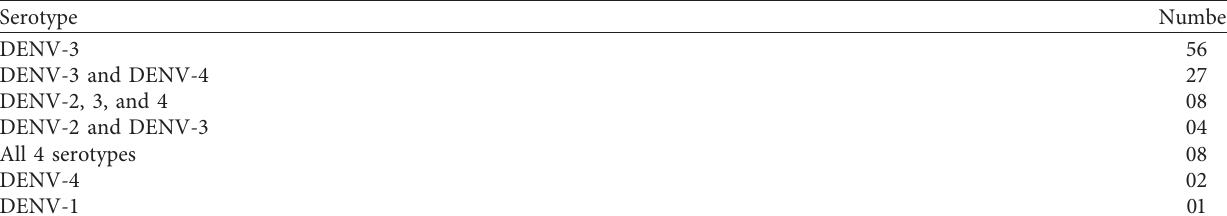
Table 3: Distribution of dengue